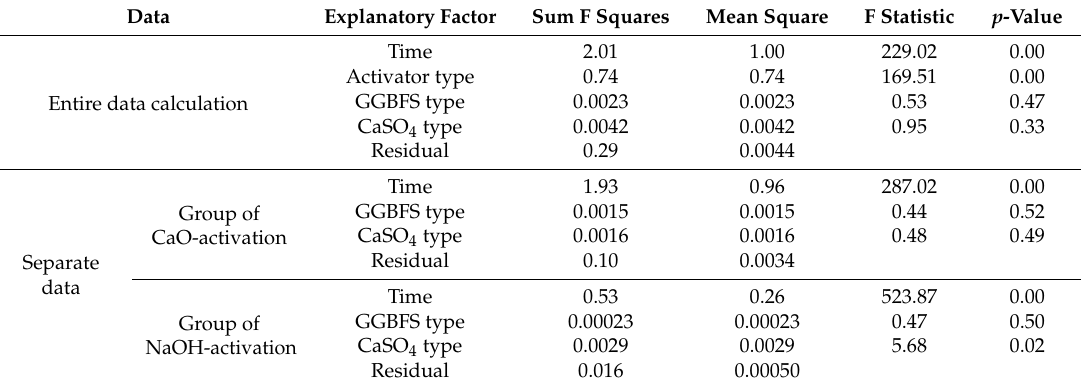
ANOVA test : all calculated values of the factorial designs from ANOVA are listed in Table A2. Table A2. Detailed calculations of the factorial designs from